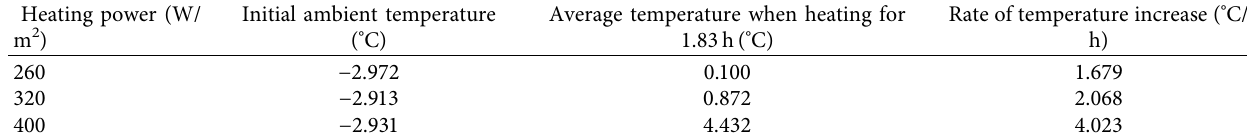
Table 6: Rates of the surface temperature increase of the test specimen at different powers. Heating power (W/ m 2